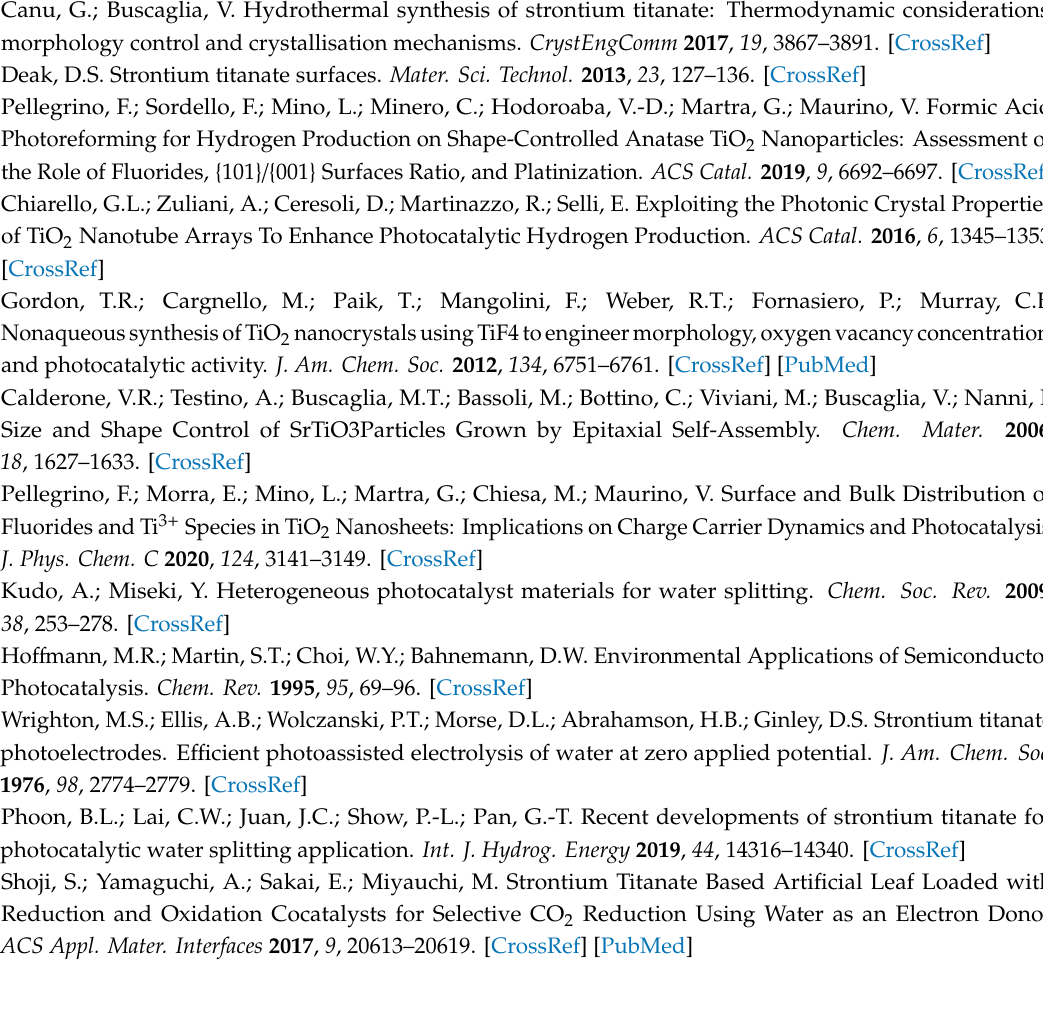
Figure S1: XRD Pattern of the reference JCPDS 01-089-4934; Figure S2: (A) SEM analysis of the microparticles synthetized without presence of SrTIO3 – 0 g. (B) STEM-in-SEM analysis of the microparticles synthetized without presence of SrTiO 3 – 0 g (same field-of-view as in (A)). (C) EDX analysis of the microparticles from (A), Figure S3: (A) SEM analysis of the particles synthetized without presence of SrTiO 3 – 5 g. B) STEM-in-SEM analysis of the same field-of-view as in (A). (C–E) EDX analysis of the particles from A, Figure S4: (A) SEM analysis of the particles synthetized without presence of SrTiO 3 – 10 g. (B) STEM-in-SEM analysis of the same particles as in Figure A. (C–E) EDX analysis of the particles from Figure (A), Figure S5: (A) SEM analysis of the particles synthetized without presence of SrTiO 3 – 20 g. (B) STEM-in-SEM analysis of the same field-of-view as in (A). (C–E) EDX analysis of the particles from